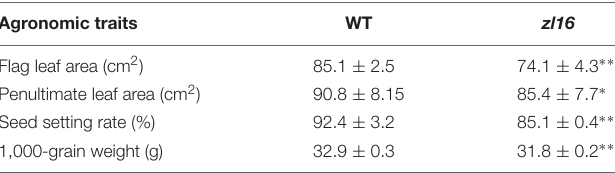
TABLE 1 | The agronomic trait comparison between the mature wild-type (WT) and zl16 mutant plants. Agronomic